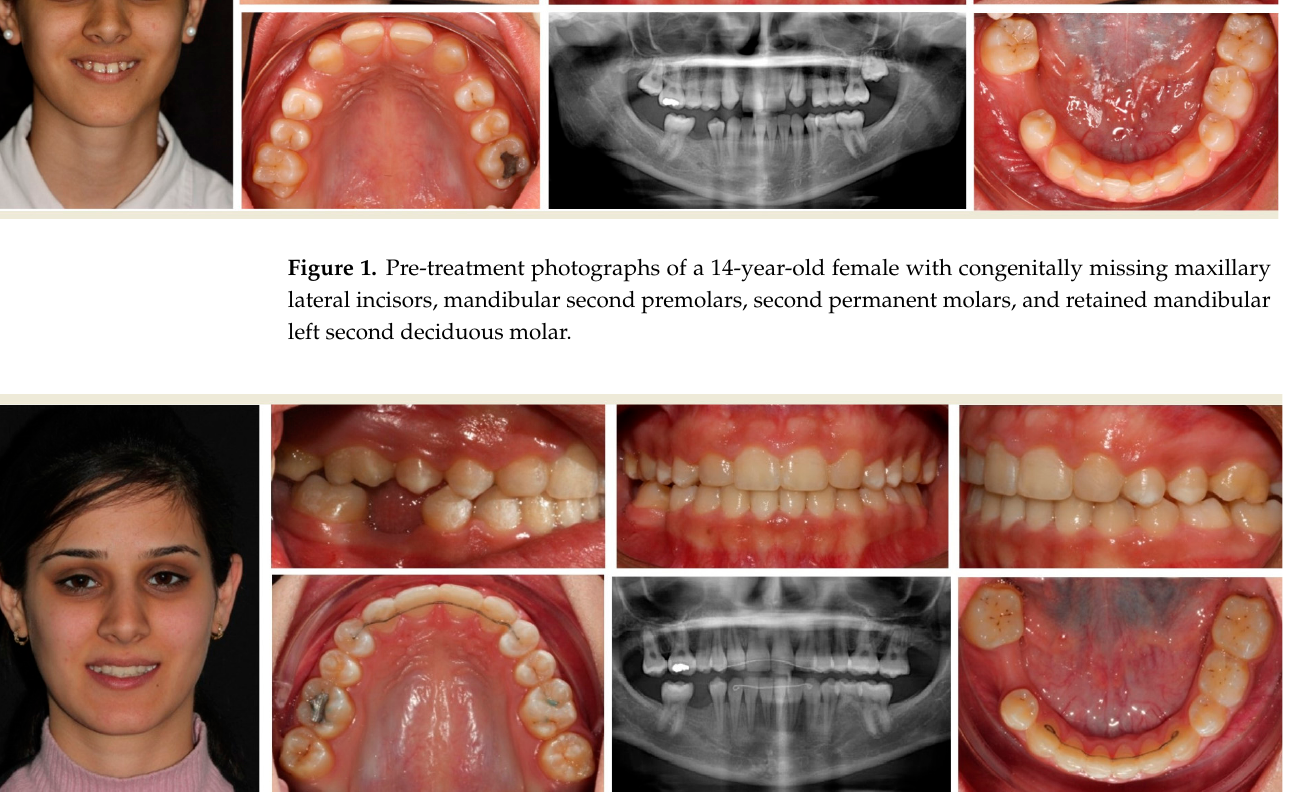
Figure 2. Post-treatment photographs with canine substitution for the missing lateral incisors.